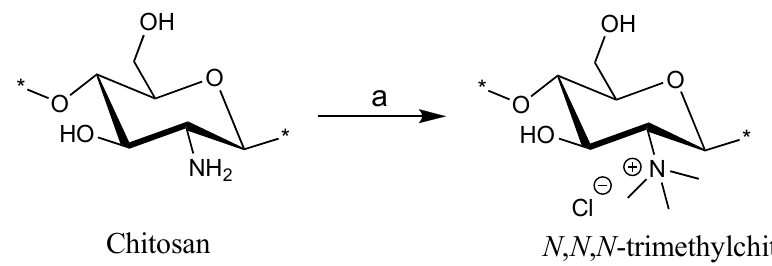
Scheme 1. Synthesis of N , N , N -trimethyl chitosan using conditions: ( a ) MeI, NaOH, DMF-H 2 O, room temperature, 48 h (these conditions were repeated 3 times).